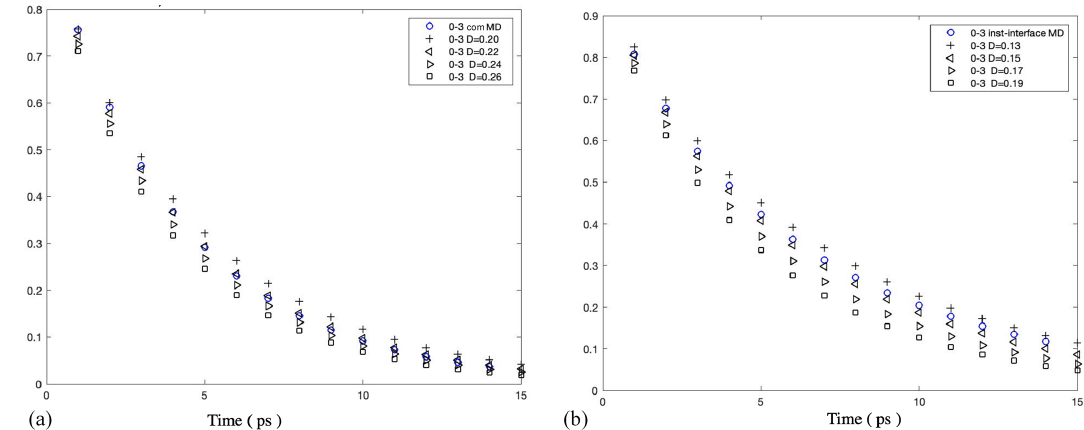
Figure A10. Survival probability of water molecules in a 0.3nm thick interfacial layer in 5000 water droplets: (a) under the com scheme and (b) under the inst scheme. The results show that D ⊥ , interface = (0 . 20 , 0 . 22)Å 2 ps − 1 under the com scheme and D ⊥ , interface = (0 . 15 , 0 . 17)Å 2 ps − 1 under the inst scheme.